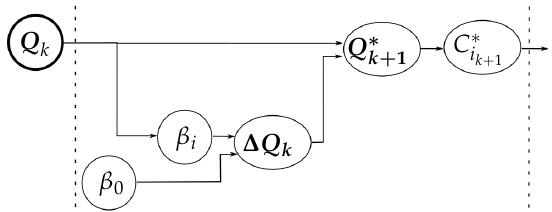
Figure 6. Variables involved in the optimization of the grasp